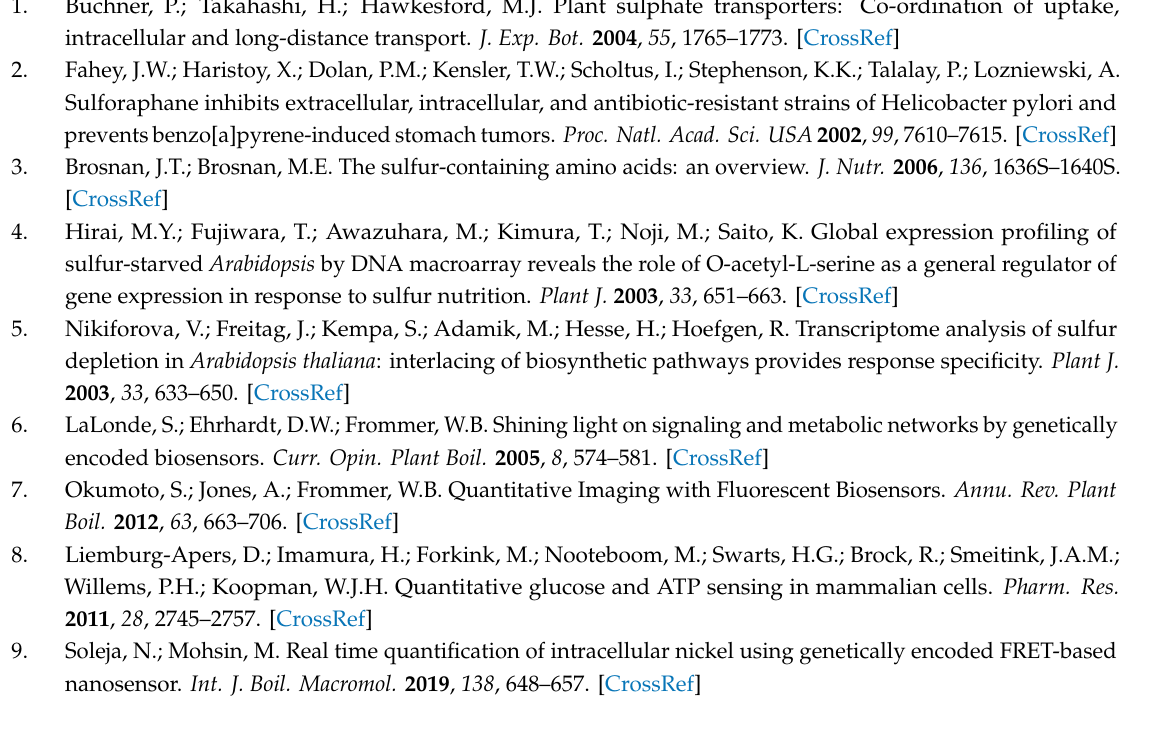
s1. Figure S1. Standard curve of sulfate concentration and FRET